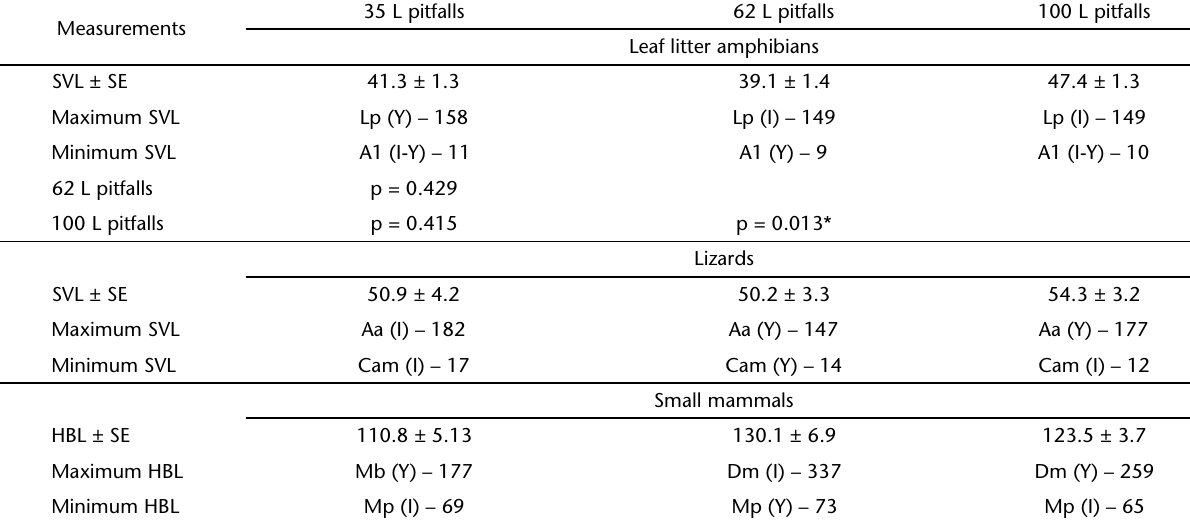
Table II. Comparison of snout-vent length (SVL, amphibians and lizards) and head-body length (HBL, mammals) captured by different trap sizes in each faunal group. First line corresponds to mean SVL or HBL ± standard deviation. Second and third lines show “species (pitfall design) – SVL or HBL” of respectively the largest and smallest animal captured by each trap size. Fourth and fifth lines show the significance level of pairwise Tukey post hoc comparisons (P). All measurements are in millimeters. Species abbreviations: (Lp) Leptodactylus paraensis , (A1) Adenomera sp. 1, (Aa) A. ameiva , (Cam) C. amazonicus , (Mb) M. brevicaudata , (Dm) D. marsupialis , (Mp) M. cf. pinheiroi